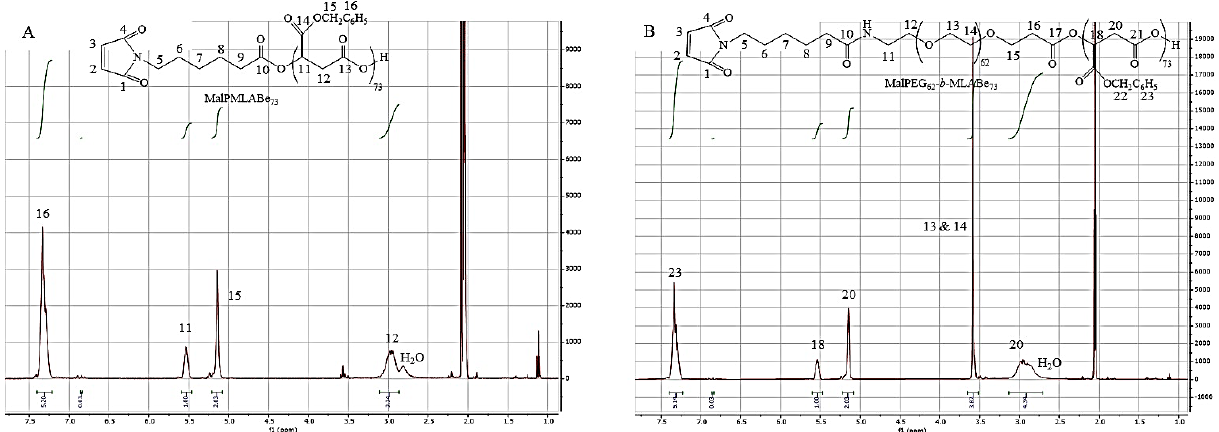
Figure 4. 1 H NMR spectra in acetone-d 6 of: ( A ) MalPMLABe 73 , and ( B ) MalPEG 62 - b -PMLABe 73 .